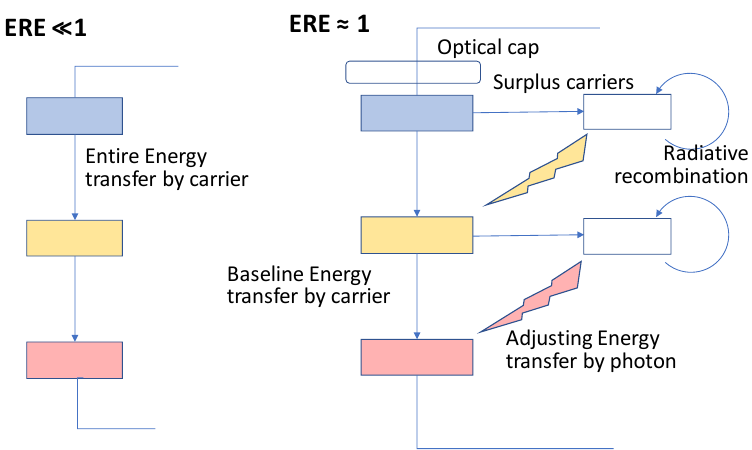
Figure 1. Theenergyflowofmulti-junctioncells. Left: Normalmulti-junctioncell;Right: Super-multi-junction Figure 1. The energy flow of multi-junction cells. Left: Normal multi-junction cell; Right: Super-multi- cell. ERE—external radiative e ffi ciency junction cell. ERE—external radiative efficiency [61].